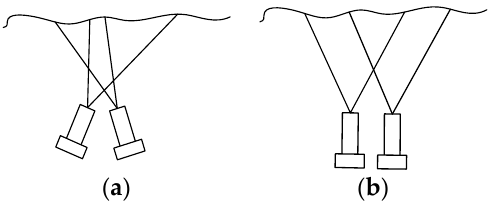
convergent type and parallel type. The two cameras of the converging binocular camera are placed at a certain angle, while the two cameras of the parallel binocular camera are placed in parallel, as shown in Figure 4. The imaging models of cameras placed in different ways are also different. Figure 4. Placement of binocular camera. ( a ) Convergent; ( b ) parallel. Because of its simple structure and easy calculation, the parallel binocular camera is widely used in the field of minimally invasive surgery. When two cameras are placed in parallel, the line between the optical centers of the two cameras is parallel to the two imaging planes, and the two optical axes are perpendicular to the imaging plane. Thus, only horizontal parallax exists in the corresponding points of the images acquired by the two cameras. When two cameras have the same focal length, the imaging geometric relationship is shown in Figure 5. 𝑂 𝑂 (cid:3039) and (cid:3045) in Figure 5 represent the optical centers of left and right cameras respec- tively. The length of 𝑂 (cid:3039) and 𝑂 (cid:3045) lines is 𝑏 , and the focal length of both cameras is 𝑓 . The coordinates of a point 𝑃 in three-dimensional space on two camera imaging planes are represented by 𝑃 (cid:3039) = (𝑥 (cid:3039) , 𝑦 (cid:3039) ) and 𝑃 (cid:3045) = (𝑥 (cid:3045) , 𝑦 (cid:3045) ) , respectively, and the coordinate of 𝑃 in the left camera coordinate system is (𝑋, 𝑌, 𝑍) . Furthermore, since the imaging point has no parallax in the 𝑌 (cid:3039) -axial direction, 𝑦 = 𝑦 (cid:3039) = 𝑦 (cid:3045) can be obtained by the similar triangle principle (4).